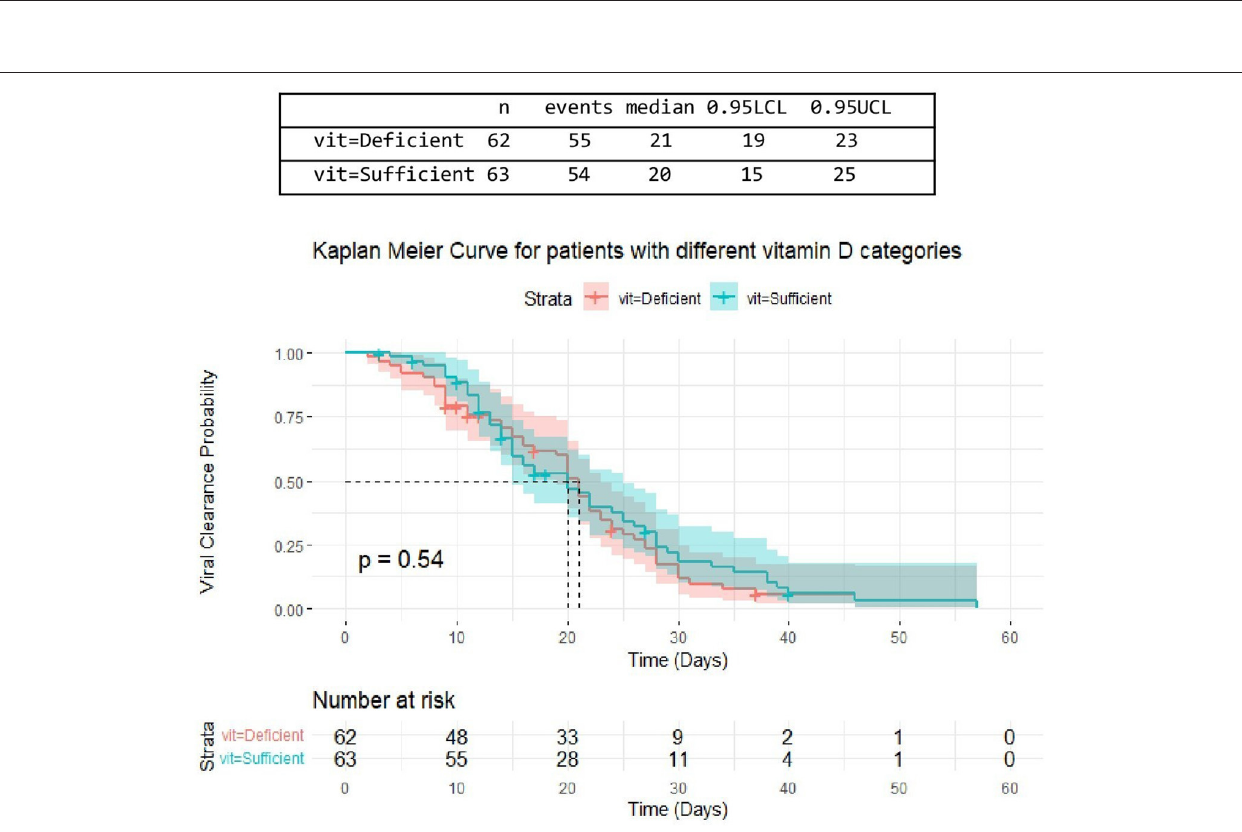
Frontiers in Medicine |